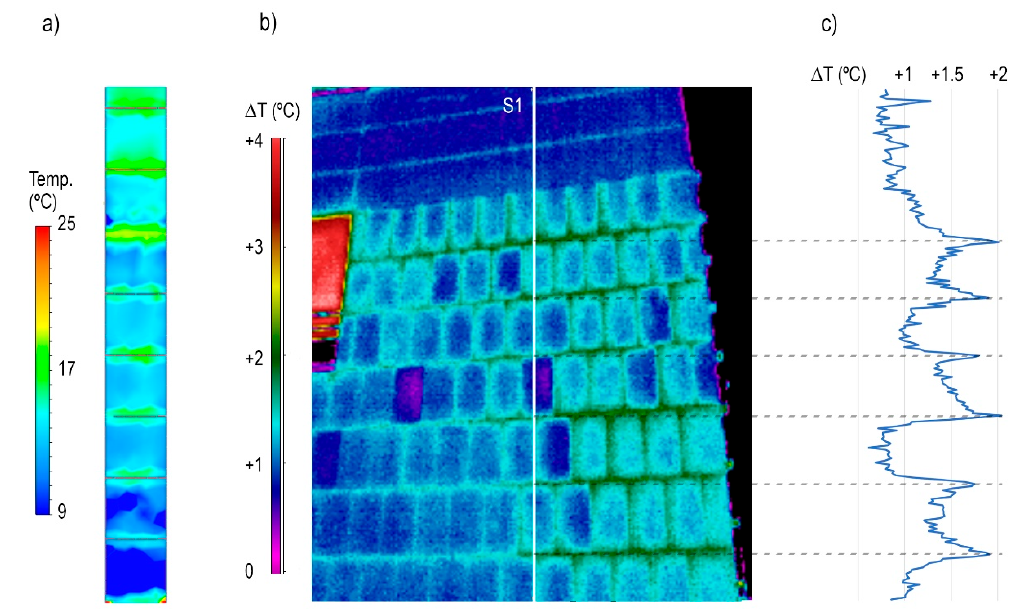
Figure 10. ( a ) Simulation of enclosure, ( b ) IRT of a real building, and ( c ) relative temperatures reached according to the vertical section S1.